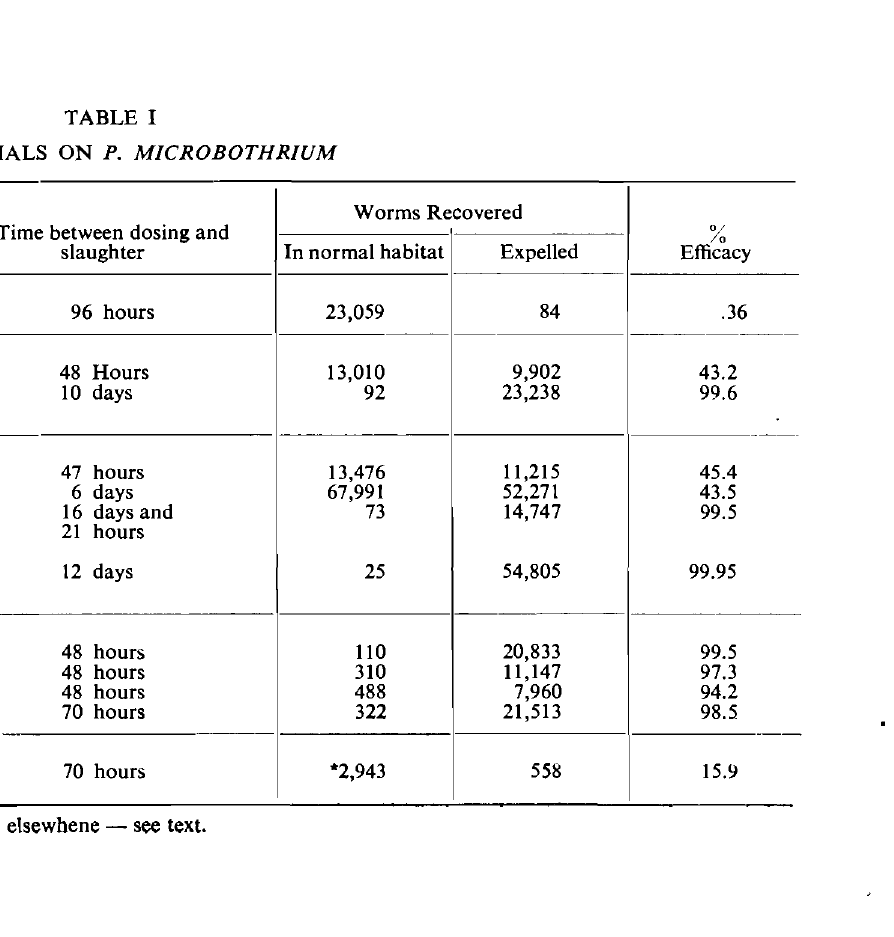
CRITICAL TRIALS ON P.